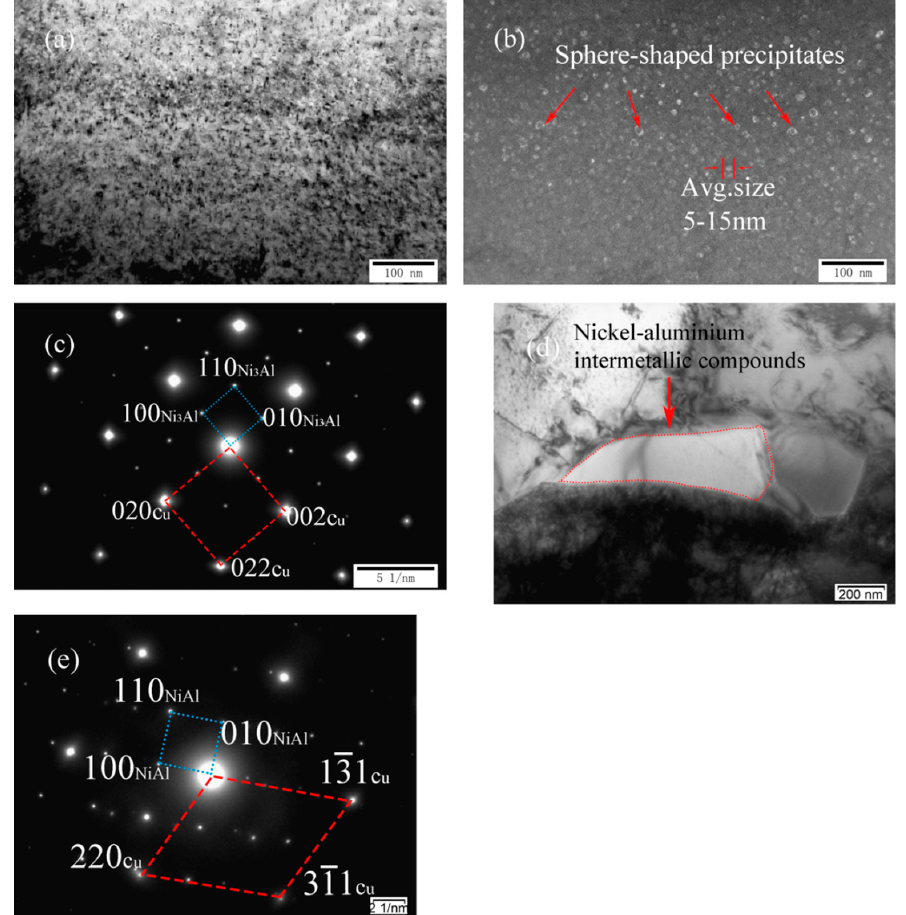
Figure 5. Microstructures of cast Cu-7Ni-5Al-1Fe-1Mn alloy: ( a ) bright-field image; ( b ) dark-field image; ( c ) the corresponding SADP of ( a ); ( d ) bright-field image in the grain boundary; and ( e ) the corresponding SADP of ( d ).